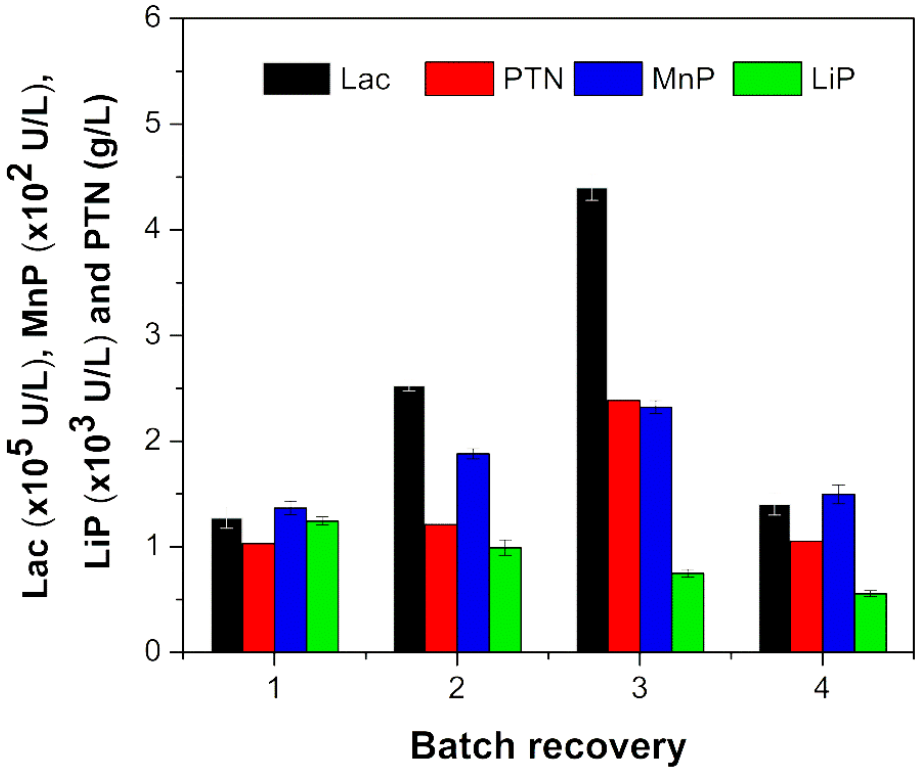
Figure 4. Ligninolytic enzyme cocktail concentrated by tangential-flow filtration per batch. As observed, after the tangential filtration steps (microfiltration and ultrafiltration), four cocktails highly rich in enzymes of the ligninolytic complex were obtained. The enzymatic activities of Lac and MnP were maximal for the third batch, while for LiP the highest enzymatic content was recorded in the first batch. The adoption of the fed-batch method proved to be efficient and allowed the obtaining of a cocktail with high enzyme contents, whose final recovery balance reached 6.8 × 10 5 , 1.4 × 10 4 and 3.5 × 10 3 U for Lac, MnP and LiP,